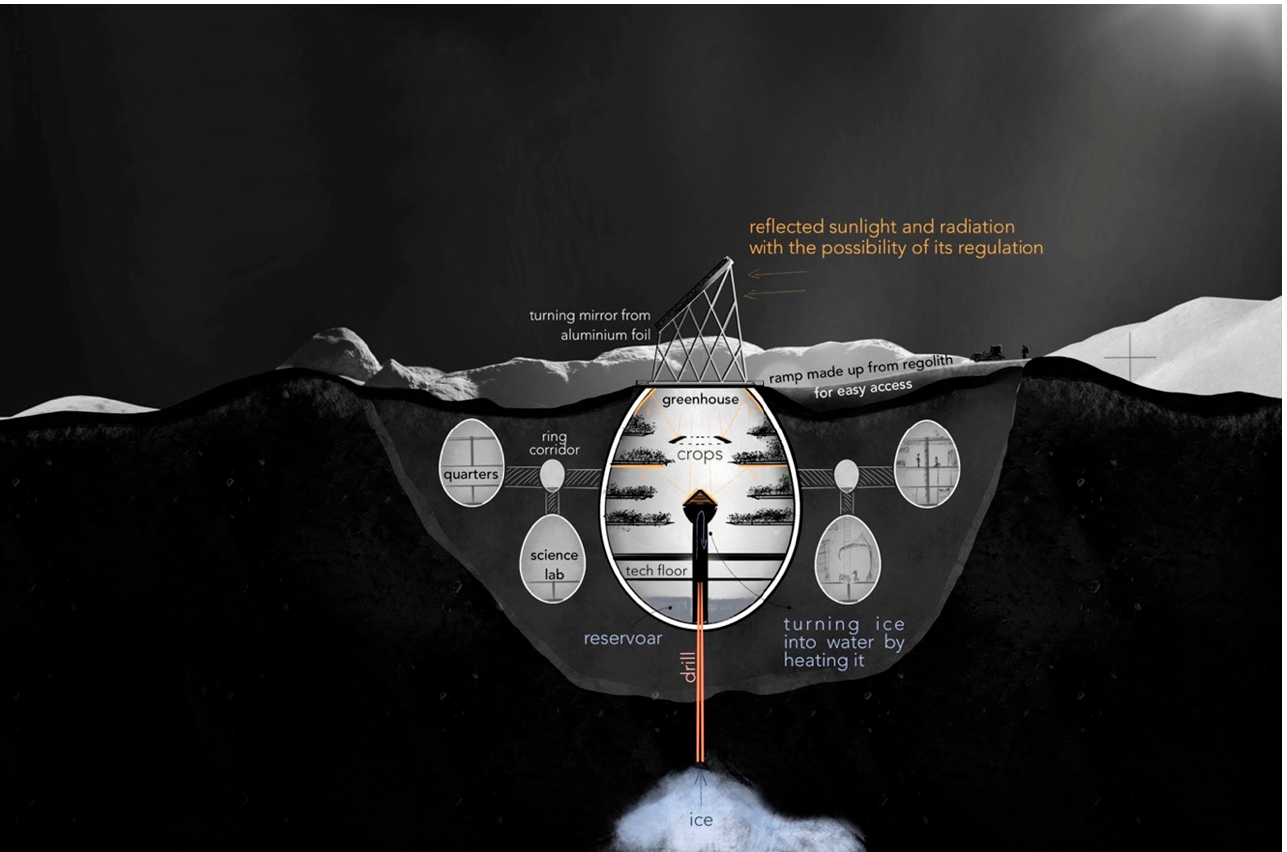
Figure 3. Concept for grouping several habitats of different size in a crater: cross-section view.